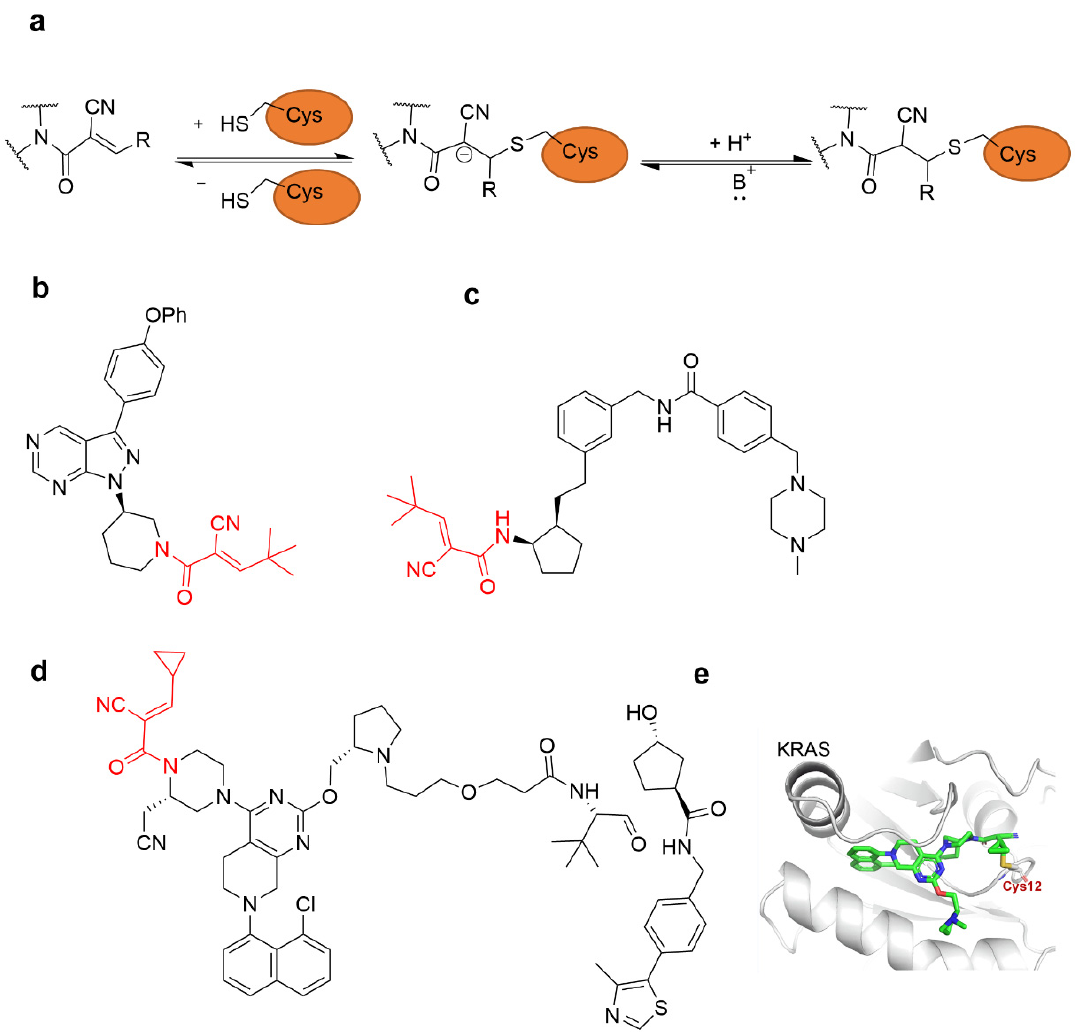
Figure 6. α , β -Unsaturated carbonyl moiety cyanoacrylamide as cysteine-targeting covalent war- heads. ( a ) Mechanism of cyanoacrylamide forming a reversible covalent adduct with cysteine. ( b ) A cyanoacrylamide-based reversible covalent BTK inhibitor. ( c ) A cyanoacrylamide-based PPAR γ phosphorylation inhibitor. ( d ) The chemical structure of designed PROTAC YF135. ( e ) The predicted binding mode of 6d (red) with KRAS G12C .